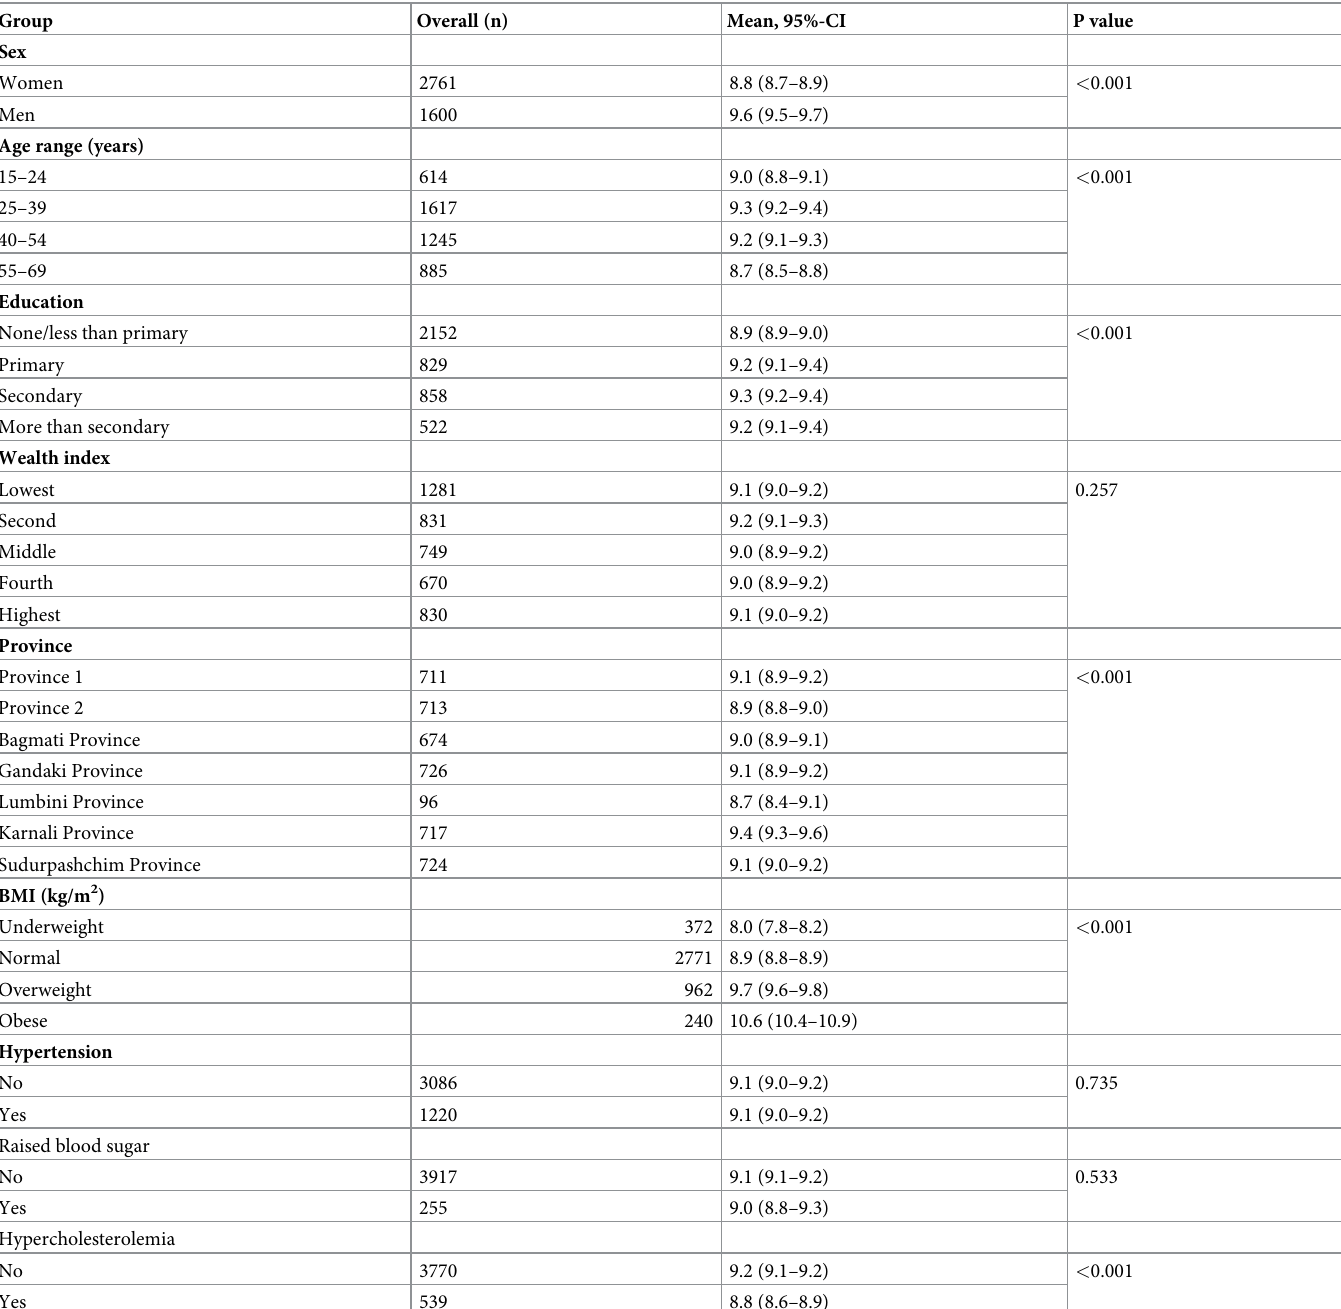
Table 3. Association between levels of salt intake with participants’